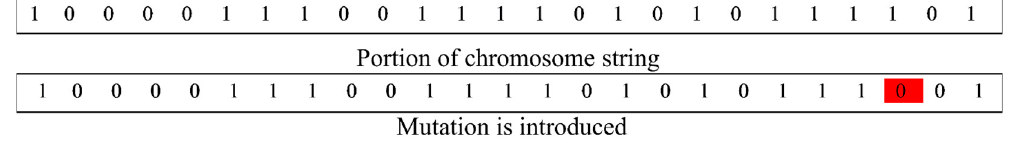
Figure 8. Mutation in a GA.